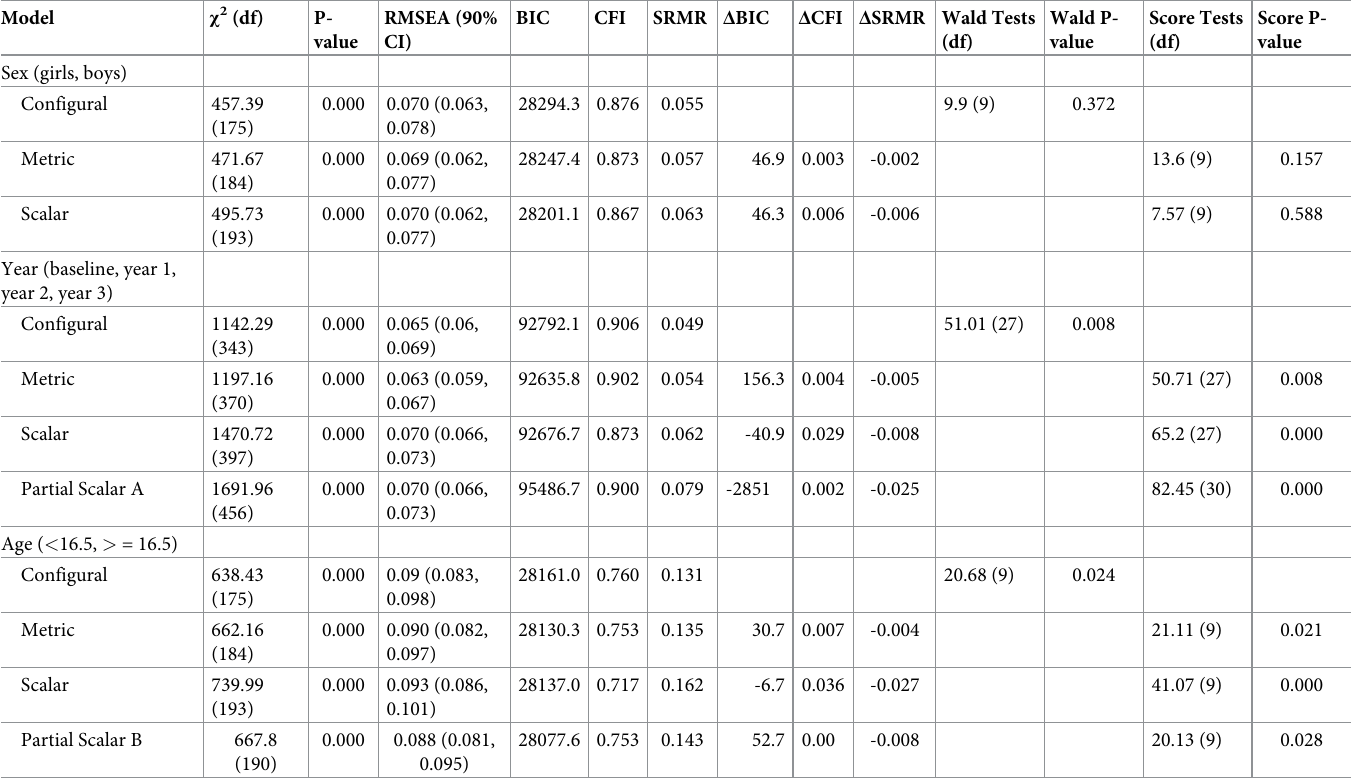
Table 3. Invariance tests for the Gur+ Model in the NCANDA